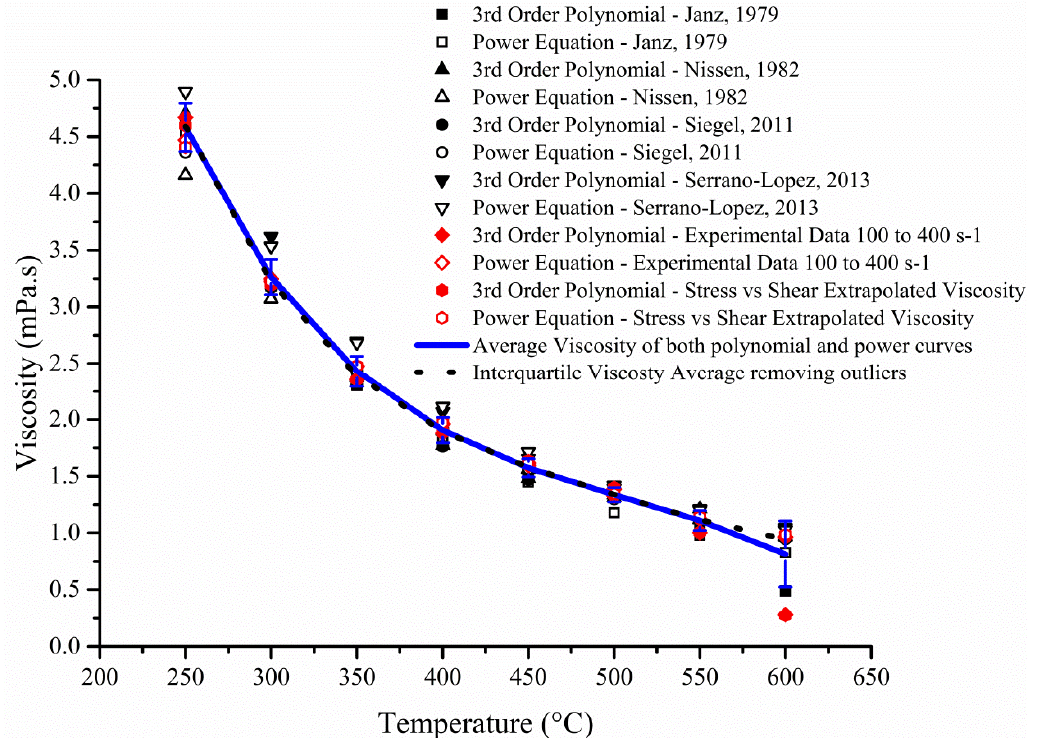
Figure 4. 3rd Order polynomial and power trend line fitted for each of the digitised